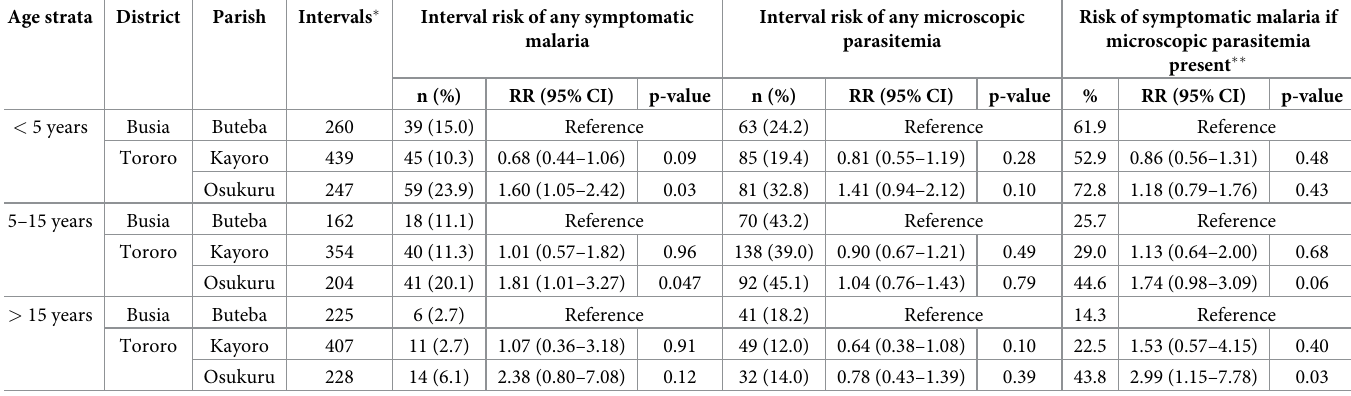
Table 4. Associations between parish and clinical outcomes stratified by